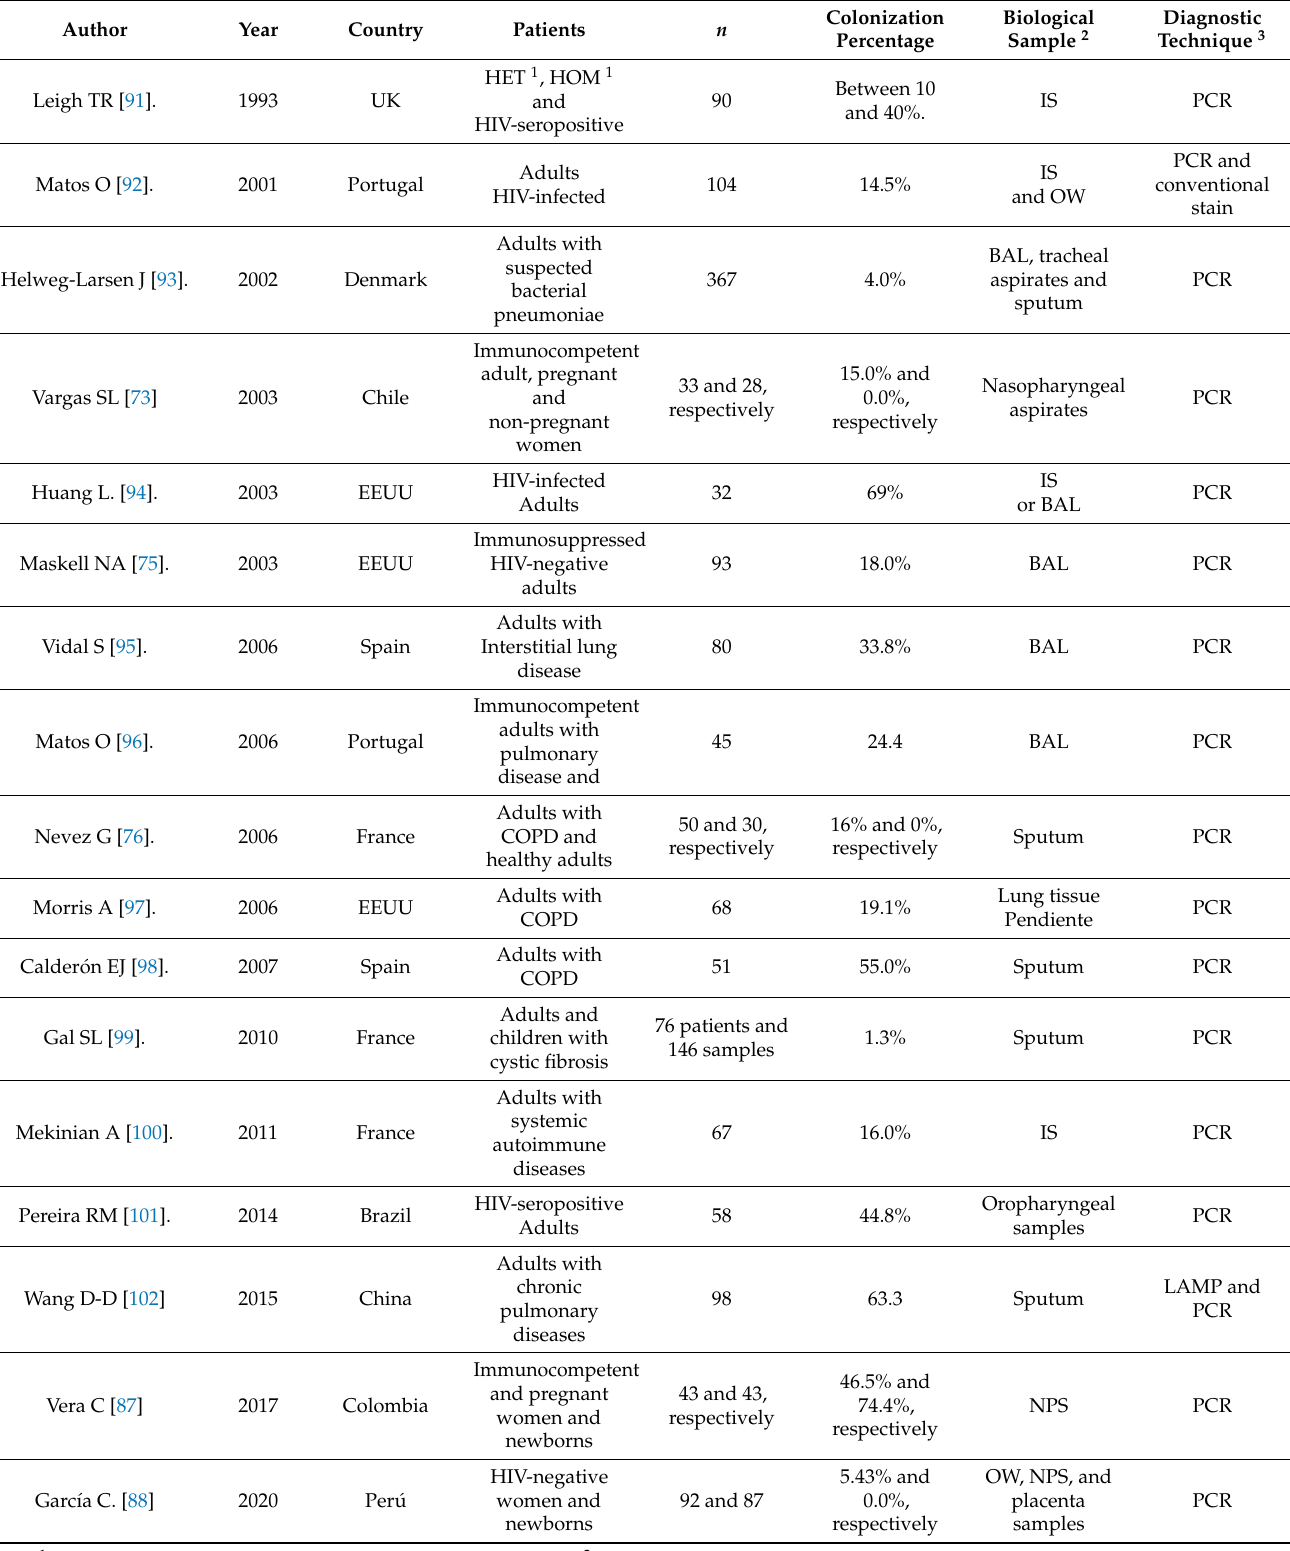
Table 1. Documented frequencies of colonization according to different clinical conditions of the